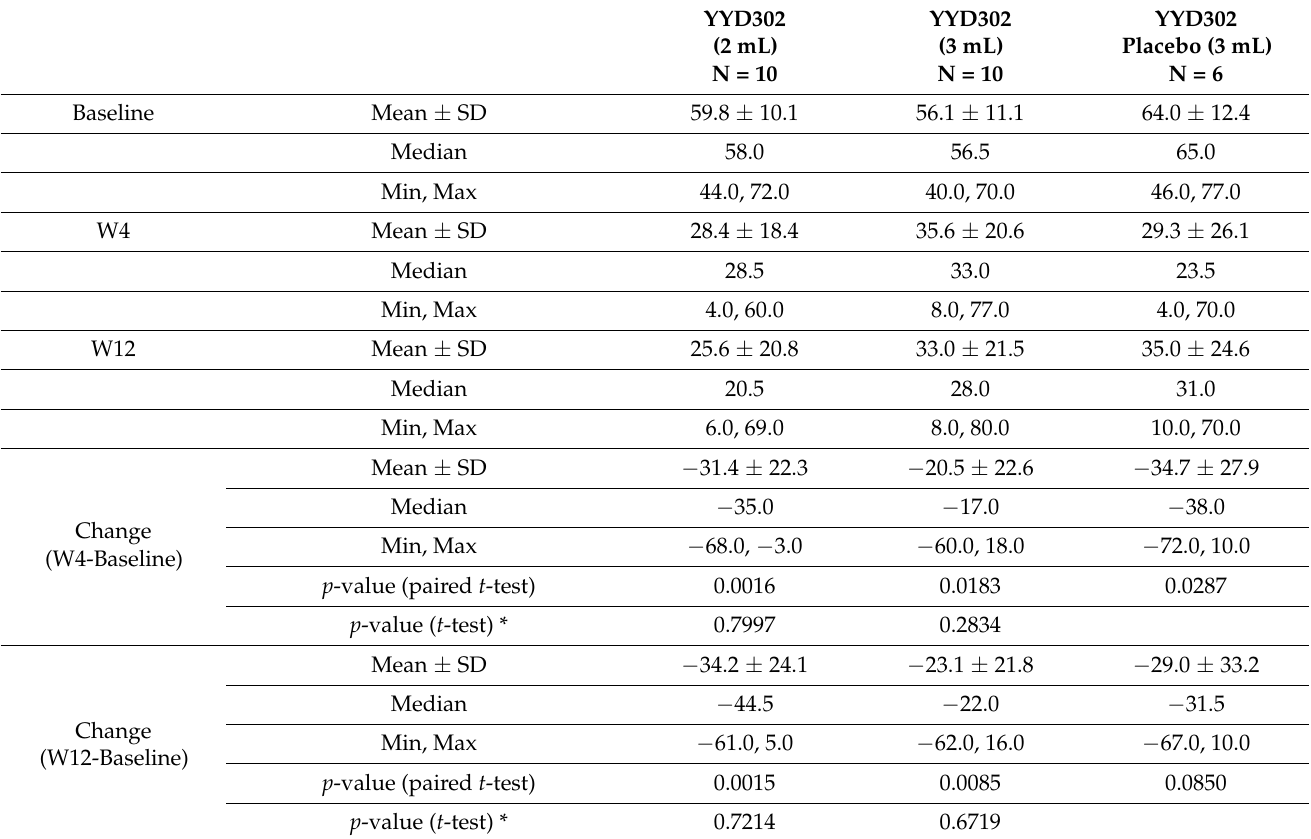
Table 2. Changes in the weight-bearing pain (100-mm VAS) at 4 and 12 weeks after administration, compared to the baseline